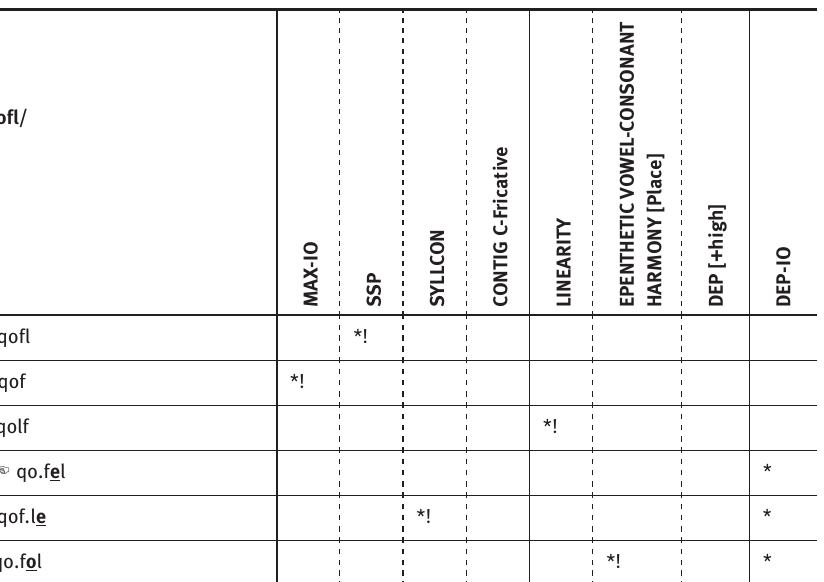
Table 12: MAX-IO, SSP, SYLLCON, CONTIG C-Fricative>>LINEARITY, EPENTHETIC VOWEL-CONSONANT HARMONY [Place],